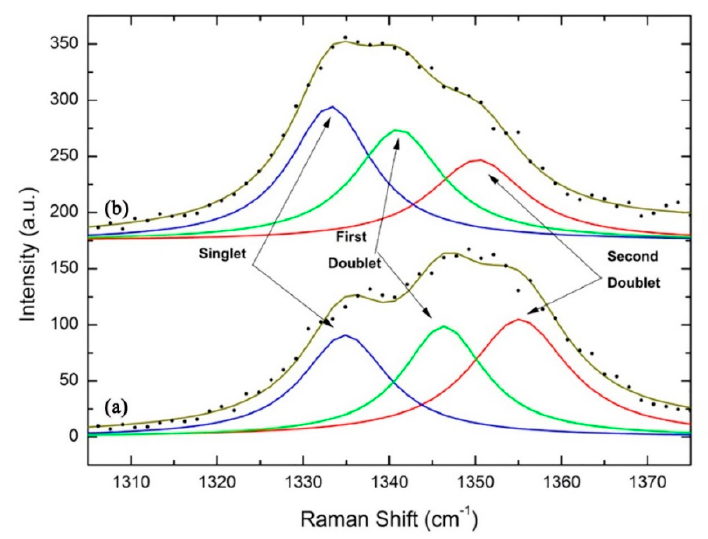
Figure 2. The singlet and doublets behavior on diamond film residual stress: ( a ) with 9 µ m and ( b ) with 31 µ m of the vanadium carbide intermediate layer. (Reproduced with permission from [31]).